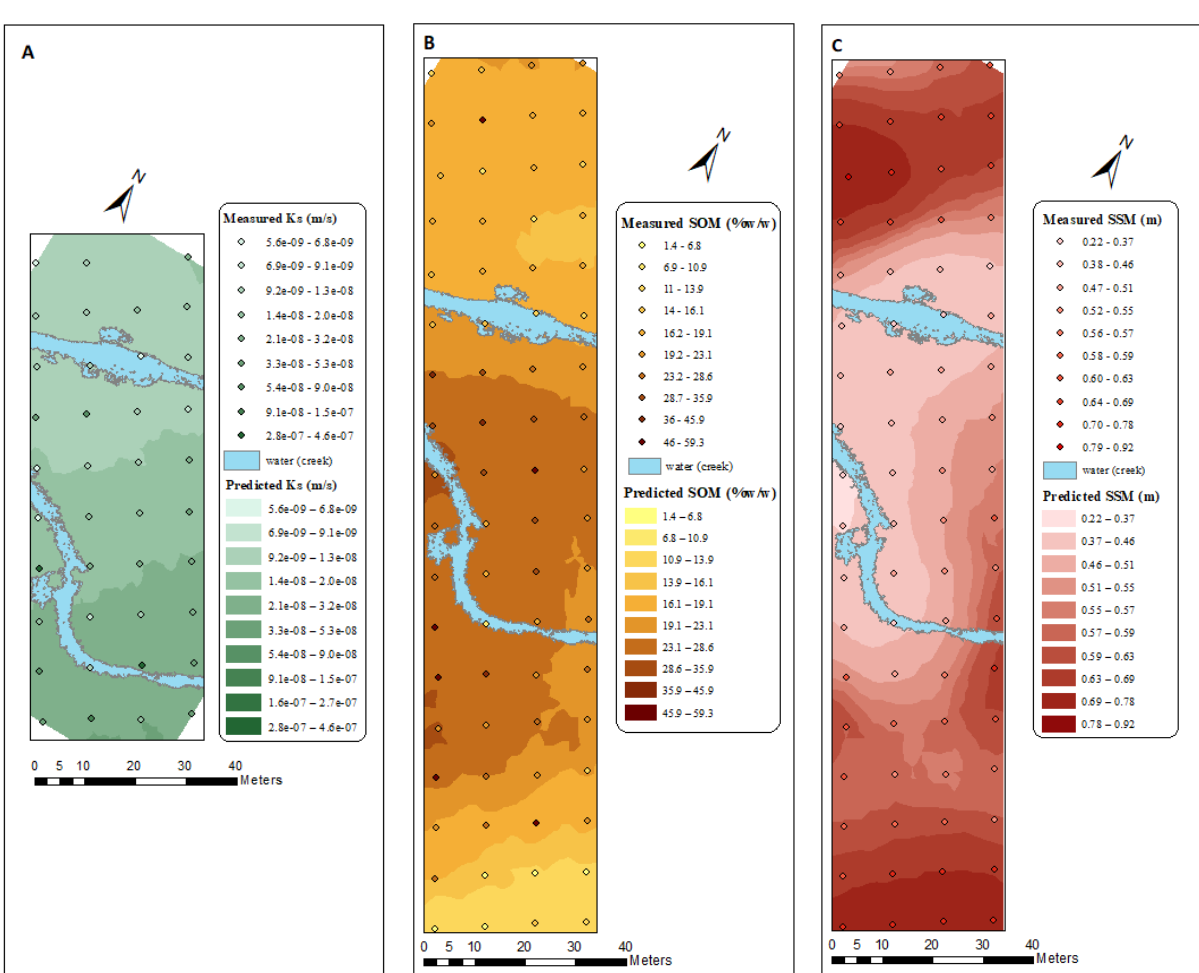
Figure 4. Contour maps showing spatial distribution of (A) K s (m s -1 ), (B) SOM (%w/w) and (C) SSM (in metres above mean sea